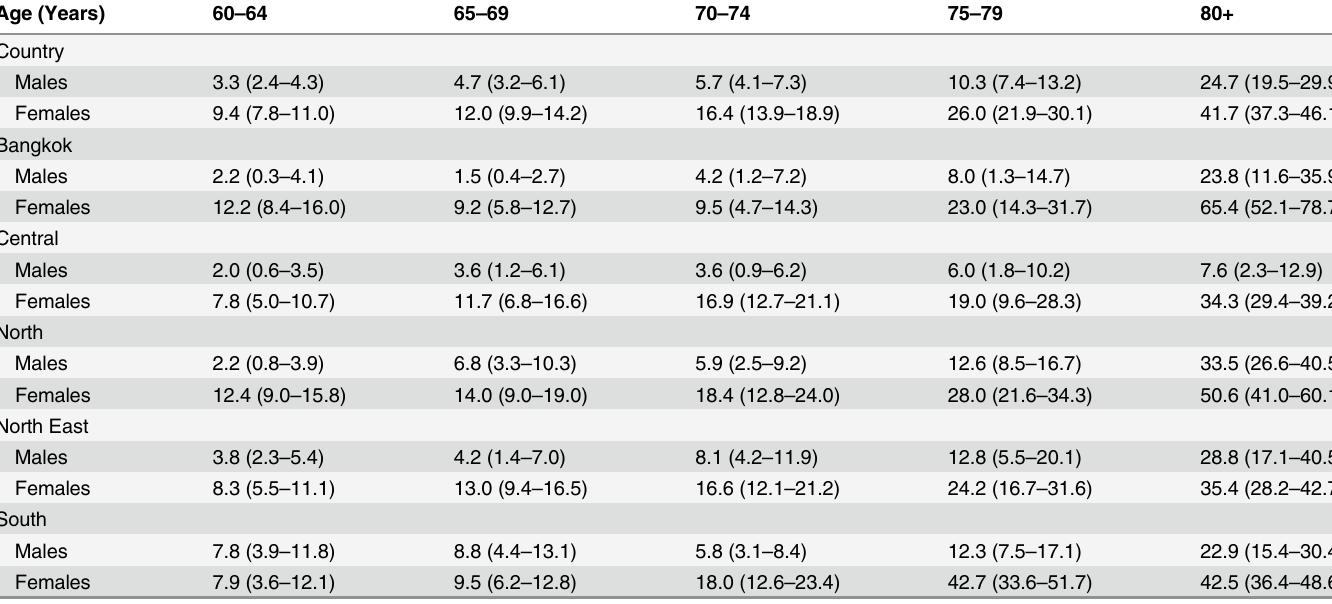
Table 2. Age- and sex- specific prevalence * (in percent) of severe mobility limitation for Thailand, and the 4 regions and Bangkok, 2009 (95%CIs in